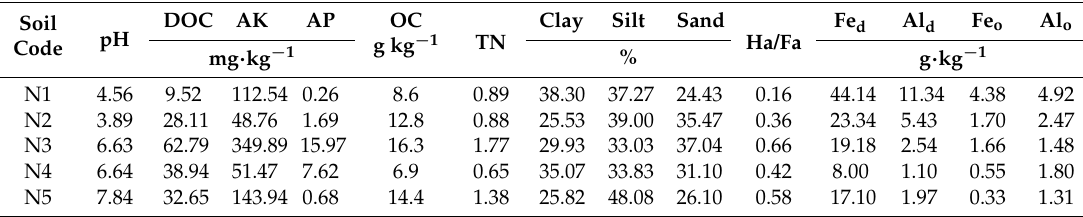
Table 1. Physical and chemical properties of the soils used in this